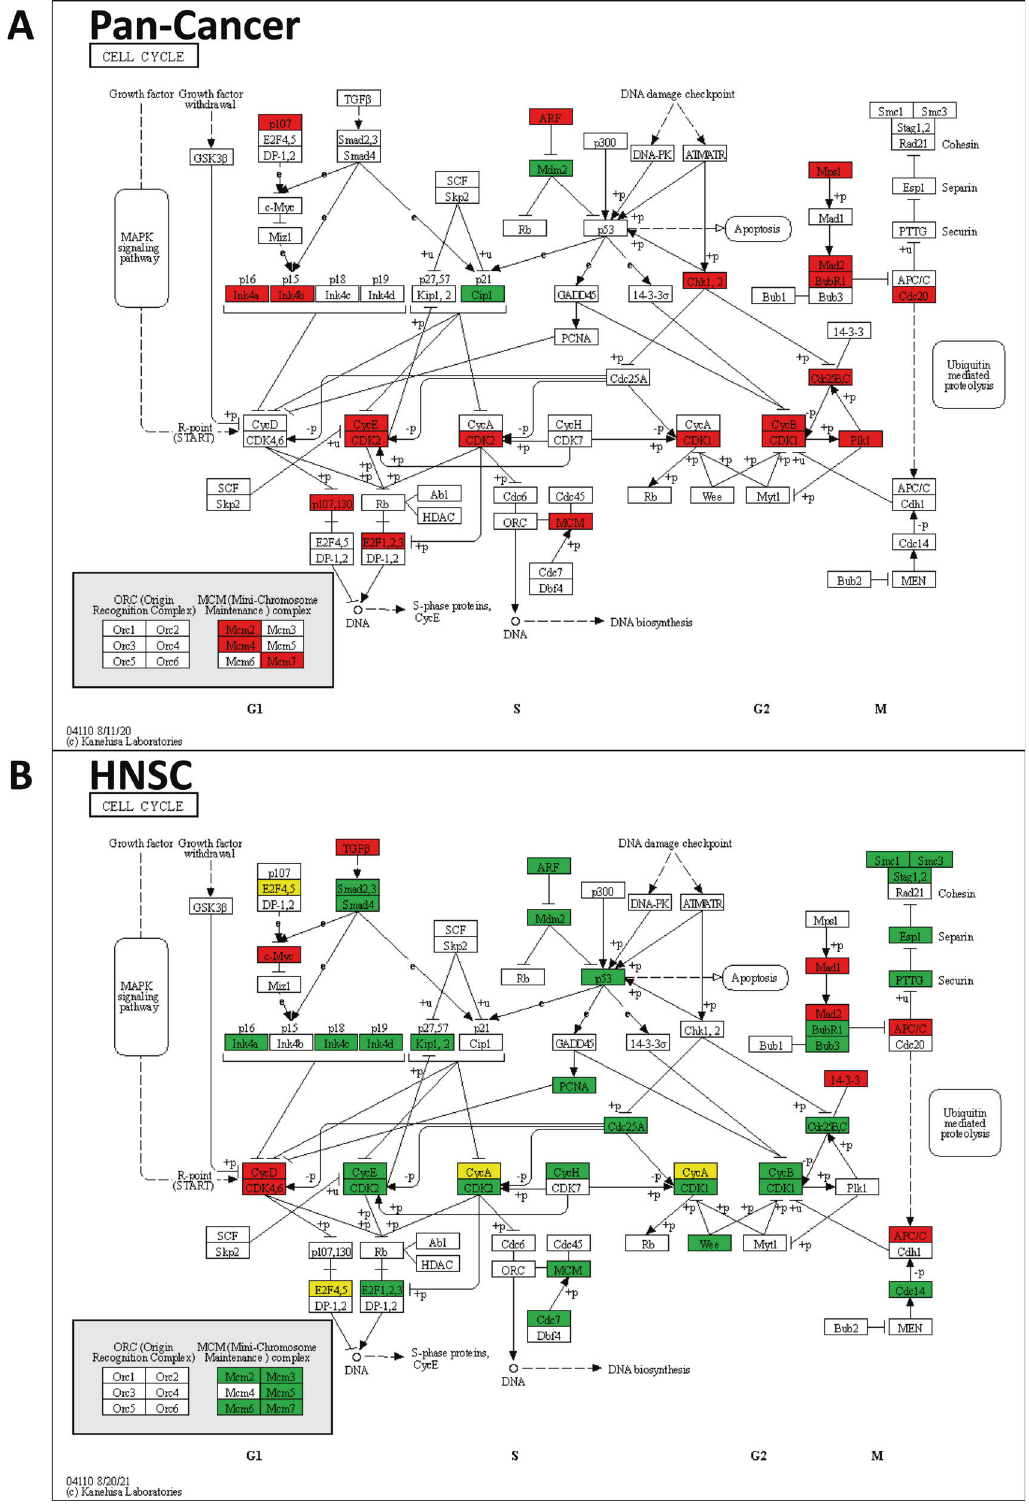
Fig. 6 Signi fi cant gene expression changes between TP53mut and TP53wt tumors in the cell cycle pathway. A Pan-cancer consensus list. B Head and neck squamous cell carcinoma (HNSC). Red = overexpressed in TP53mut tumors. Gree n = underexpressed in TP53mut tumors. Yellow = over- and underexpressed